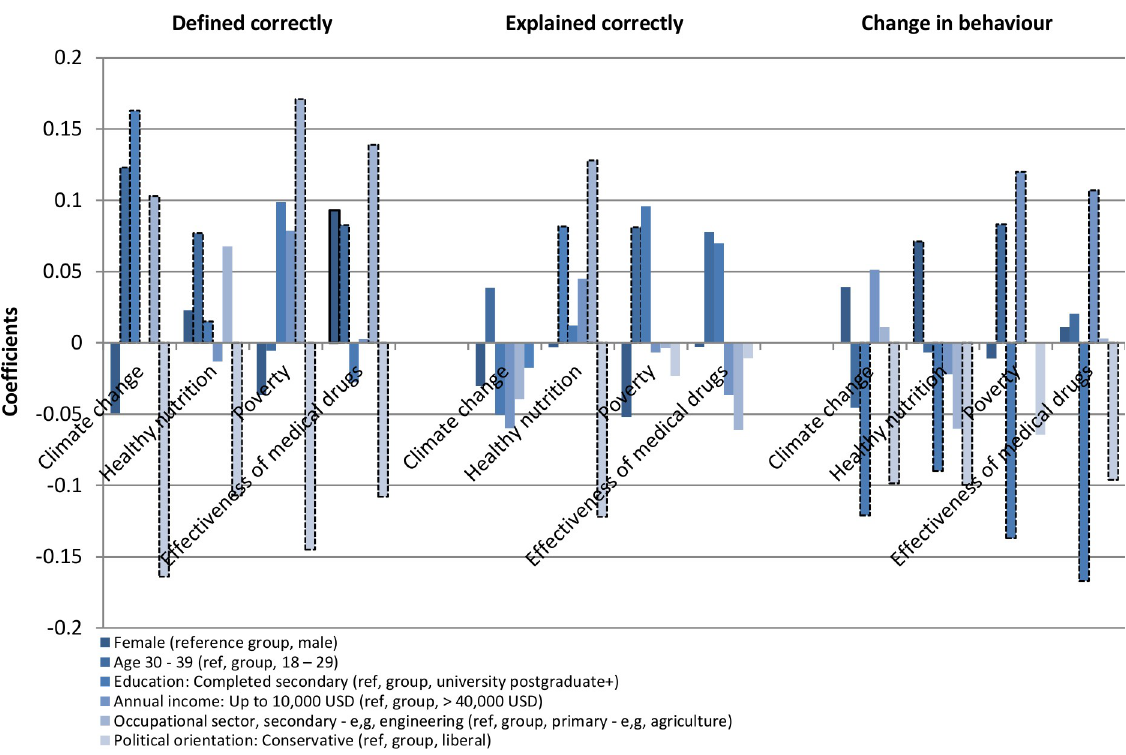
Fig 2. Estimated marginal effects of the traits and conditions of people that predict their ability to correctly define and explain, and change their behaviour, related to climate change, healthy nutrition, poverty and effective medical drugs. Statistically significant coefficients at p < 0.1 or higher are reflected with a black dashed